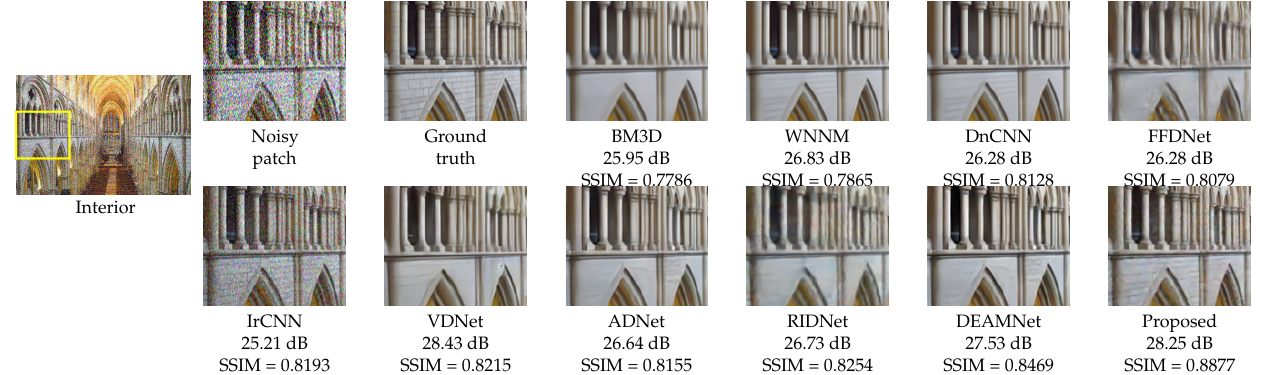
Figure 9. Visual quality comparison with PSNR and SSIM scores for “Interior” from the Urban100 dataset with AWGN noise level σ = 50 (for best view, zooming in is